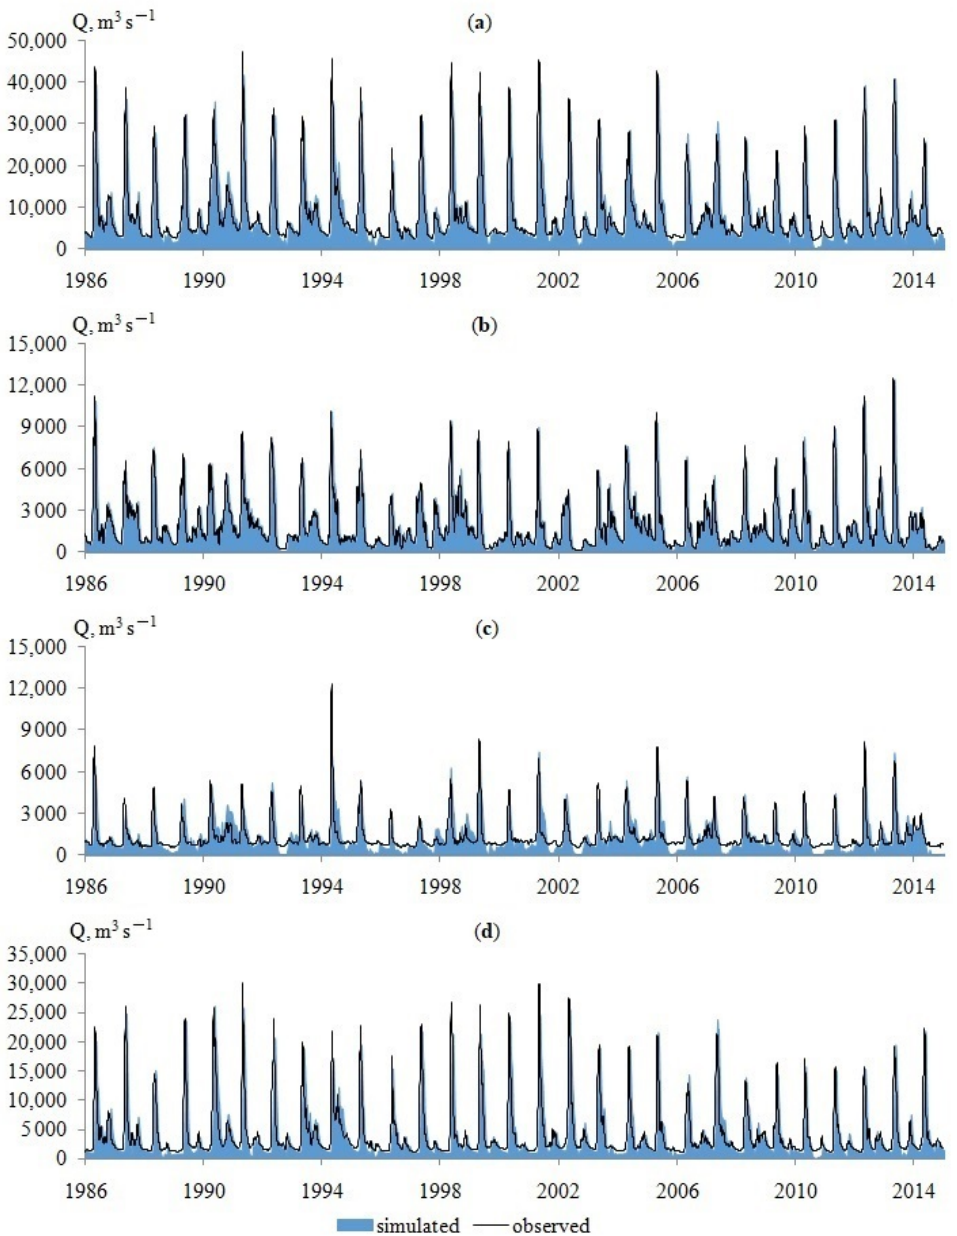
Figure 2. Hydrographs of calculated and observed daily discharges at outlet gauges of the Volga ( a ), Upper Volga ( b ), Oka ( c ) and Kama ( d ) rivers.